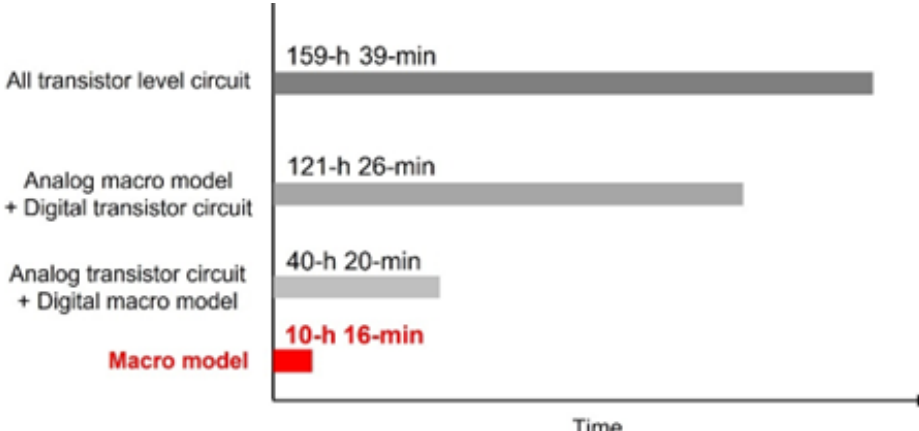
Figure 12. Simulation time comparison for the transistor circuit and macro model sigma‒delta modulator.